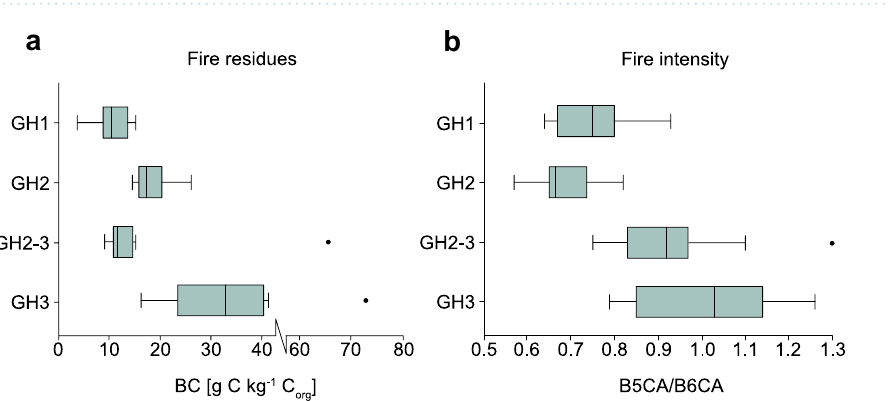
Figure 4. Black carbon analyses from Române ș ti- Dumbrăvi ț a I. ( a ) Black carbon contents as determined by BPCA analysis in the four geological horizons; ( b ) black carbon quality as indicated by B5CA/B6CA ratios in the four geological horizons. Increasing values represent low temperature fires, a shift to lower values points to higher combustion temperatures.